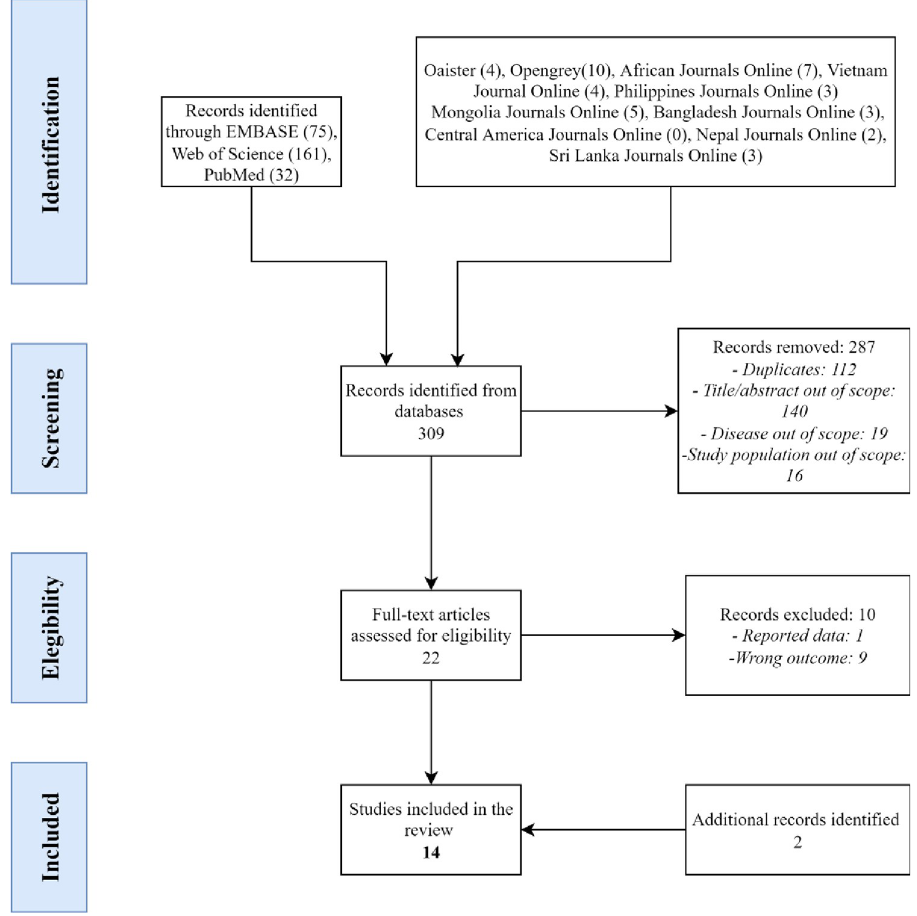
Fig 1. Flow chart of selected studies.